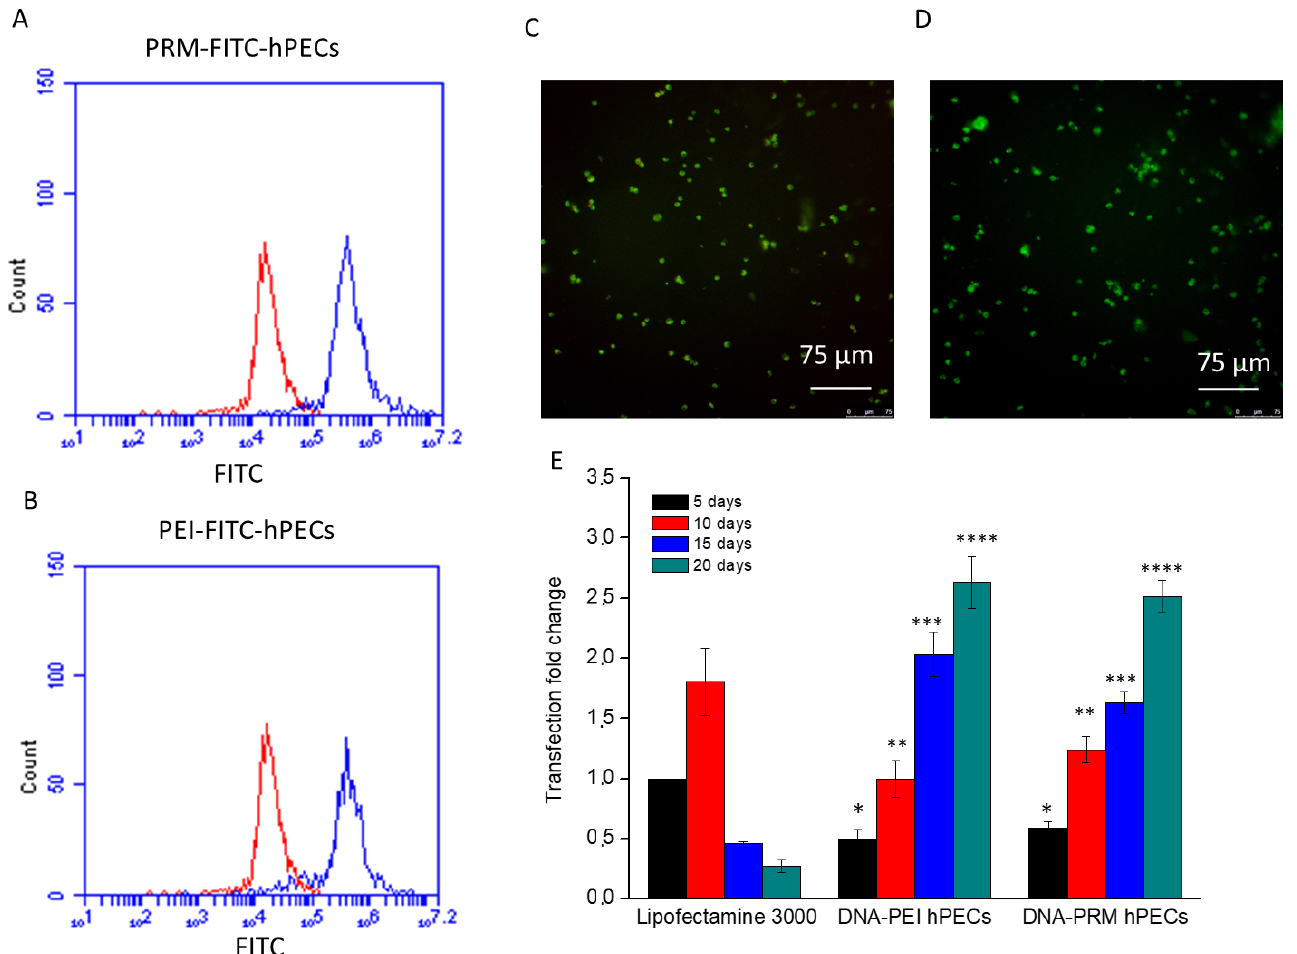
Figure 3. Cytofluorimetry analysis of FITC-PRM-hPEC (( A ), blue line) and FITC-PEI-hPEC (( B ), blue line) uptake by THP-1 cells and relative CLSM merge images of FITC-PRM-hPECs ( C ) and FITC- PEI-hPECs ( D ) after 24 h of treatment. Non-treated cells (CTR) were used as control (red line in ( A , B )). Scale bars: 75 µm. Cytofluorimetry analysis ( E ) of treated THP-1 cells in order to evaluate the transfection, expressed as fold change over time. Lipofectamine 3000 transfection was assigned an arbitrary value of 1, and the transfection efficacy of hPEC formulations was normalized to the efficiency of lipofectamine 3000 (absolute value of transfection of Lipofectamine 3000 was 15.5%). DNA refers to EGFP plasmid. Representative measurements of three distinct sets of data. *, **, ***, **** indicate p -values < 0.05 for Student’s t -test. To analyze how stable the transfection induced by hPECs was over time, plasmids carrying the EGFP gene were loaded into PEI- and PRM-hPECs, and the transfection was conducted on a macrophage precursor cell line (THP-1). During all the experiments, the cell culture medium was never completely replaced. Instead, additions to the medium were made in order to avoid hPEC removal. The cytofluorimetry results (Figure 3E) indicate that the transfection efficacy, expressed as fold change using Lipofectamine 3000